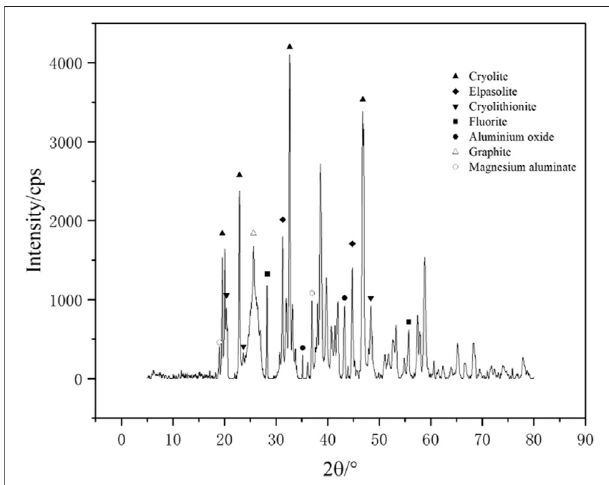
FIGURE 3 | X-ray diffraction analysis results of anode carbon